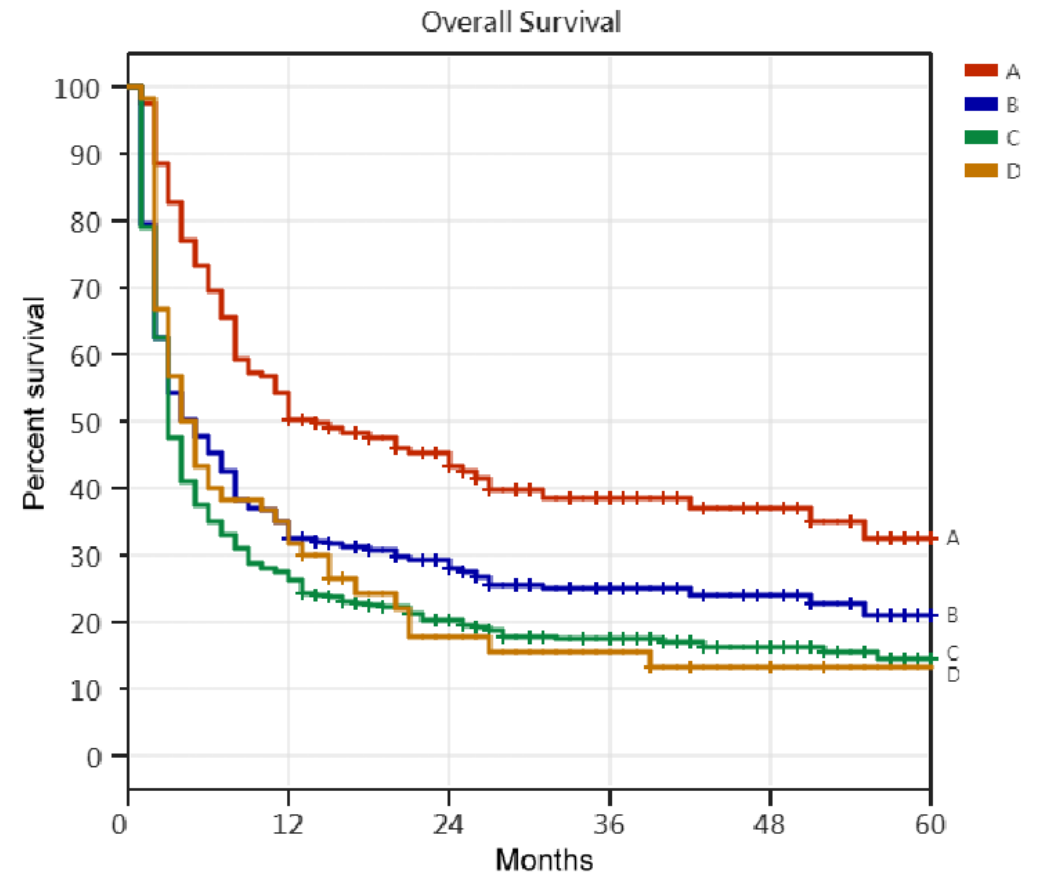
Figure 2. The Kaplan–Meier curve of prolonged mechanical ventilation patients, successfully weaned prolonged mechanical ventilation patients, patients discharged after successfully weaned from prolonged mechanical ventilation, and respiratory care word patients. 1. A: 157 discharged PMV patients: B: 243 successfully weaned PMV patients; C: 403 PMV patients; D: 60 respiratory care ward patients. 2. 157 discharged PMV patients vs. 403 PMV patients: p < 0.001, HR = 2.166; 157 discharged PMV patients vs. 60 RCW patients: p < 0.001, HR = 1.965; 157 discharged PMV patients vs. 243 successfully weaned PMV patients: p < 0.001, HR = 1.658; 60 RCW patients vs. 403 PMV patients: p = 0.148, HR = 1.246; 60 RCW patients vs. 243 successfully wended PMV patients: p = 0.575, HR = 0.920; 243 successfully weaned PMV patients vs. 403 PMV patients: p = 0.001, HR = 1.374. 3. The study found that the five-year survival rate of respiratory care ward patients was similar to that of patients who had been successfully weaned from prolonged mechanical